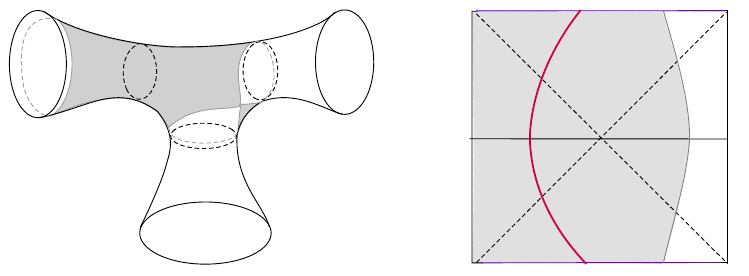
Figure 22 . (Left) The shaded region denotes the part of the t = 0 Cauchy slice covered by a patch of BTZ coordinates. (Right) The Lorentzian patch of the BTZ spacetime correspoding to one asymptotic region. The EOW brane is shown in